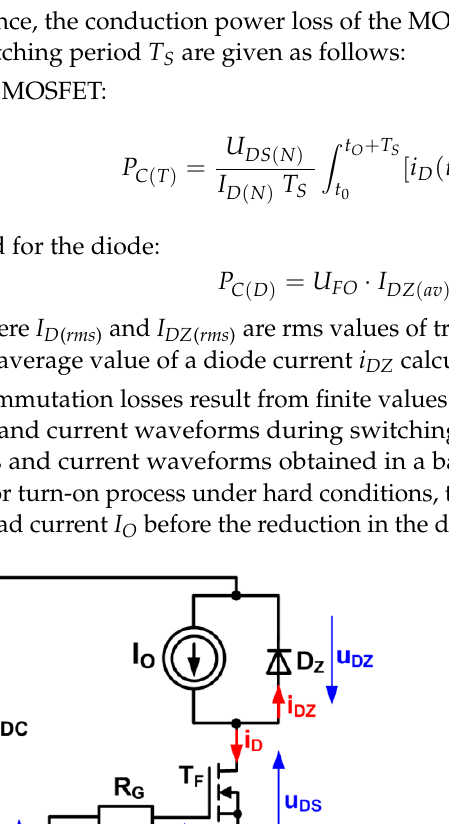
Figure 6. Basic switching cell.